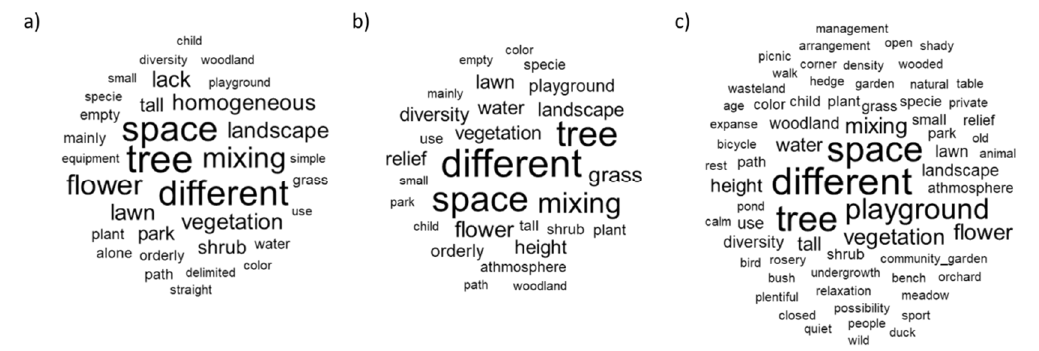
Figure 2. Word-clouds representing the corpus of answers given by visitors who scored their perception “1–2”, “3”, and “4–5”. Word-clouds are named, respectively ( a – c ). The size of each word is correlated to its frequency of occurrence and the most frequent words are represented in the center. Table 1. List of the 23 words common across the three word-clouds (in alphabetical order) with their rank based on their occurrences. Word-clouds a, b and c refer to Figure 2.